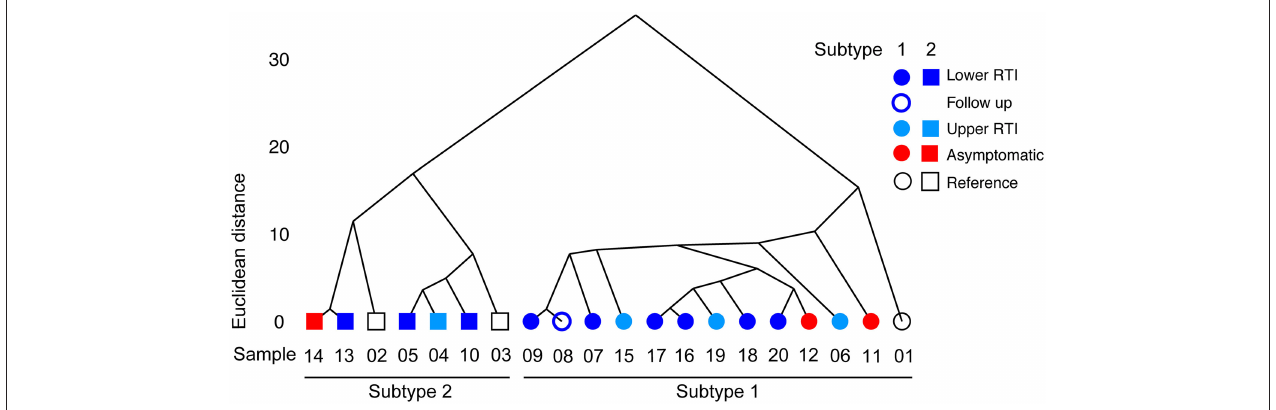
FIGURE 1 | Hierarchical clustering based on Euclidean distance. The Euclidean distance between variant frequencies (on the y-axis) is plotted against the different strains sequenced in this study. The strains are indicated by their sequence ID listed in Table 1 . Only the variants with a frequency above 0.2 were used in this analysis (see the text for details). Hierarchical clustering was applied based on Euclidean distance and the average linkage method